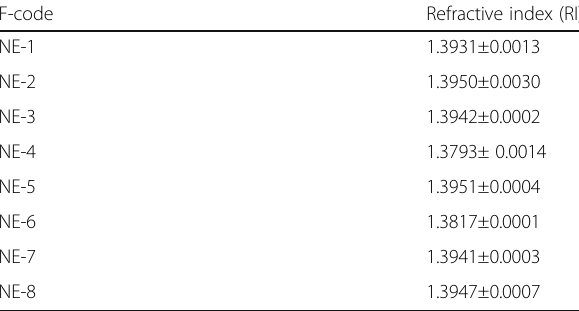
Table 7 Refractive index results of candesartan cilexetil